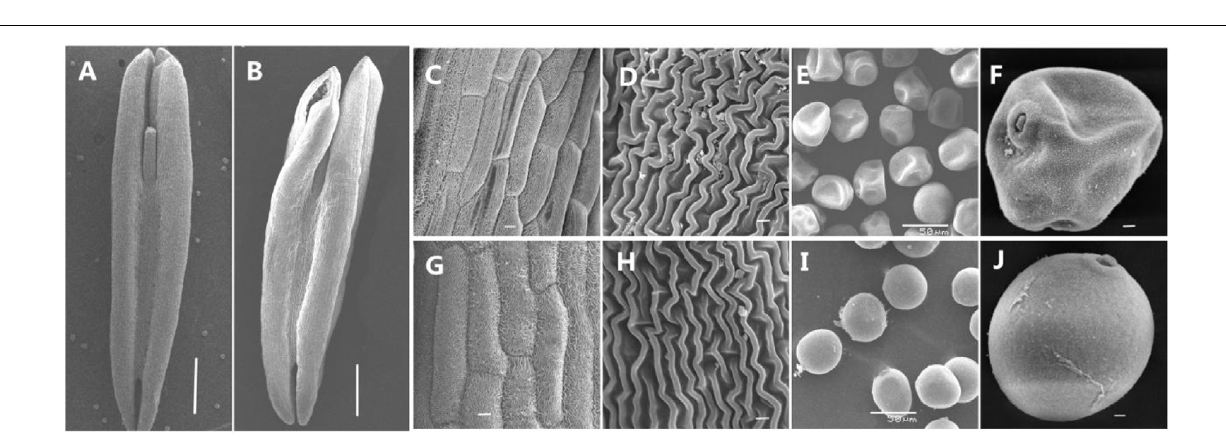
FIGURE 3 | Comparison of scanning electron micrograph observations in AS (A,C–F) and AF (B,G–J) at the trinucleate stage. (A,B) Anther; (C,D,G,H) outer epidermal cells; (E,F,I,J) trinucleate cells. Scale bars are 1000 µ m in (A,B) ; 100 µ m in (C,G) ; 50 µ m in (E,I) ; and 30 µ m in (D,H,F,J) .